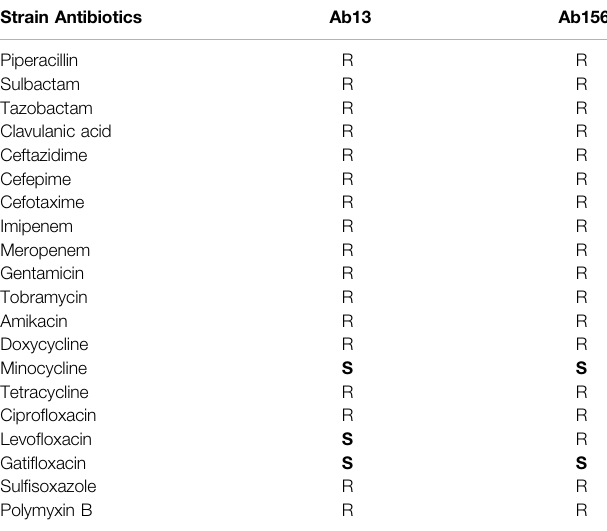
TABLE 1 | Antibiotic resistances of clinical A. baumannii strains Ab13 and Ab156. R represent resistance. S represent sensitive. Strain